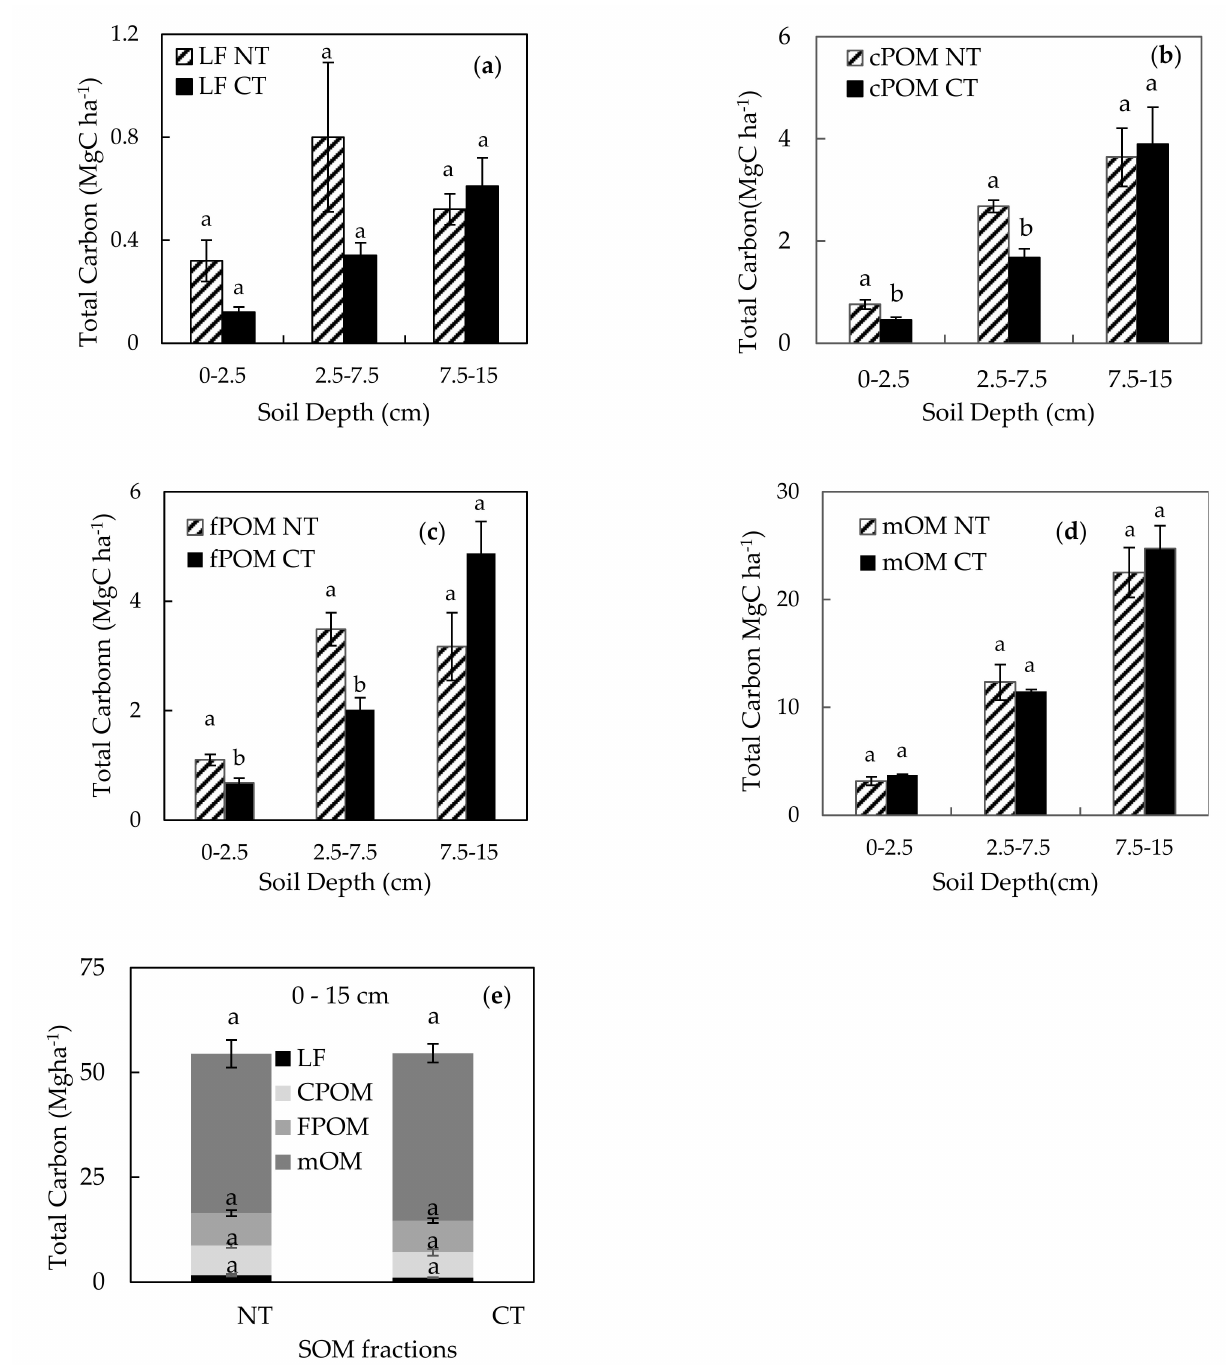
Figure 5. Total carbon content (MgC ha − 1 ) of SOM fractions (light fraction (LF); ( a ), coarse-POM (c-POM); ( b ), fine-POM (f-POM); ( c – e ) silt+clay (mOM) by physical fractionation of Andosols from the no-tillage (NT) and rotary (RT) system-cultivated land under ryegrass (RY) at various depths. Bars indicate the standard error ( n = 4). Different letters show significant differences for the tillage treatments of each soil depth, according to Student’s t -test ( p <